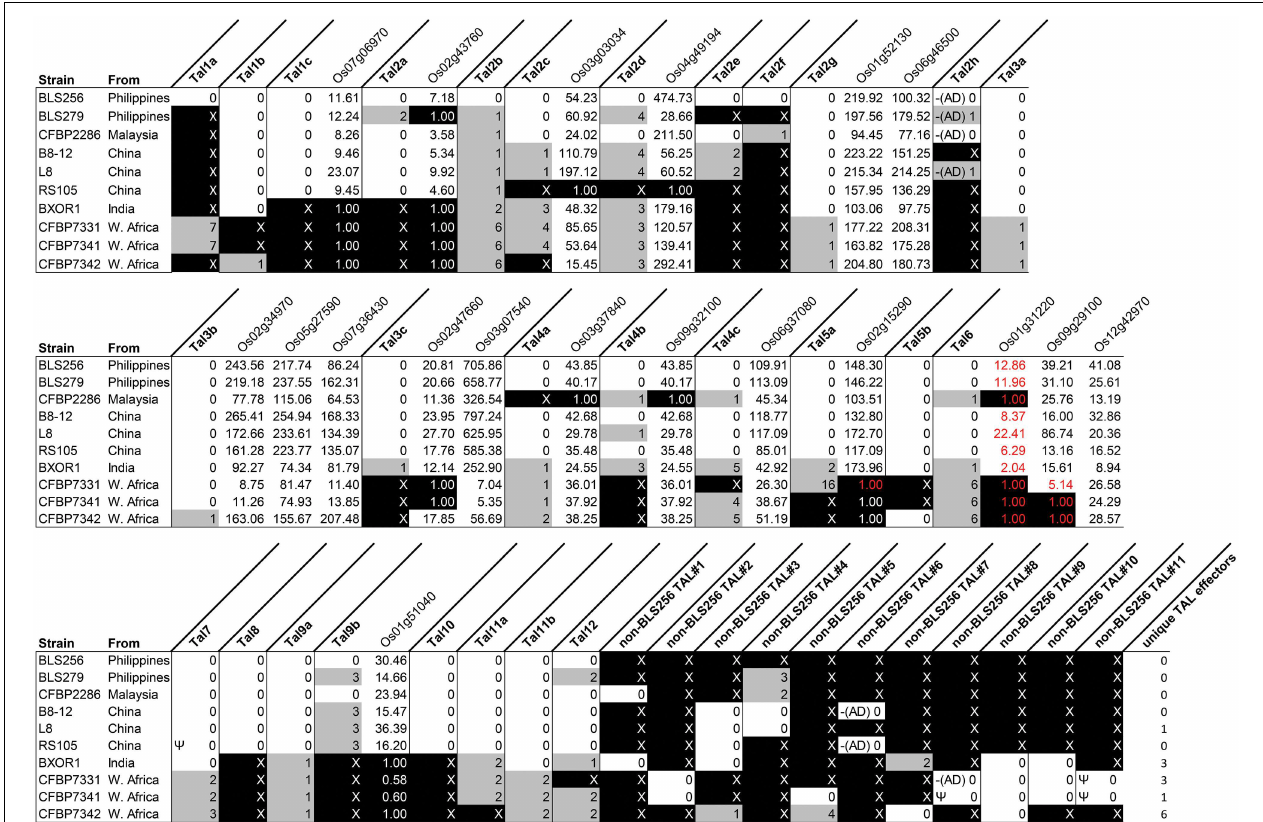
black fill, indicates absence of an ortholog. “ 9 ” indicates that the TAL effector sequence derives from a pseudogene. “–(AD)” indicates a C-terminus like that of BLS256 Tal2h, missing the activation domain. Columns labeled in regular font with a rice gene name (locus ID) show the fold upregulation of that gene by each strain, with black fill indicating genes that are not significantly upregulated. The genes are grouped by the BLS256 TAL effector that upregulates them, immediately to the right of the column for that TAL effector. Fold change values in red font mark instances in which the gene promoter has no predicted EBE that passes a machine learning filter for the BLS256 TAL effector ortholog present in the strain represented in that row.